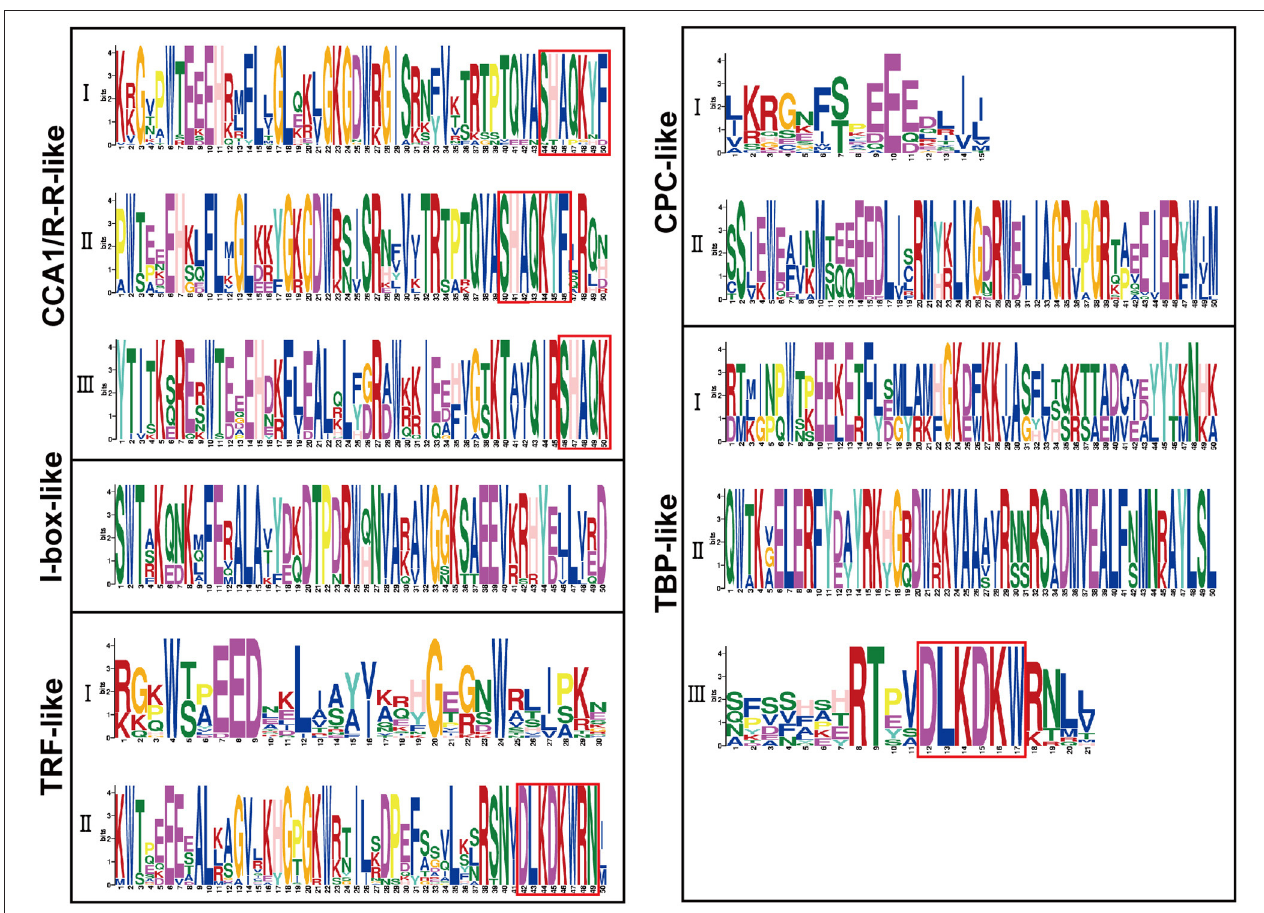
FIGURE 3 | Amino acid sequence logos of the MYB domains in BnMYB-related proteins. Bit score indicates the information content for each position in the sequence. The conserved Trp (W) residues distributed in the amino acid sequence of MYB domains, and red boxes indicate the conserved motifs. The corresponding clades based on the phylogenetic tree ( Figure 2 ) are indicated on the left for